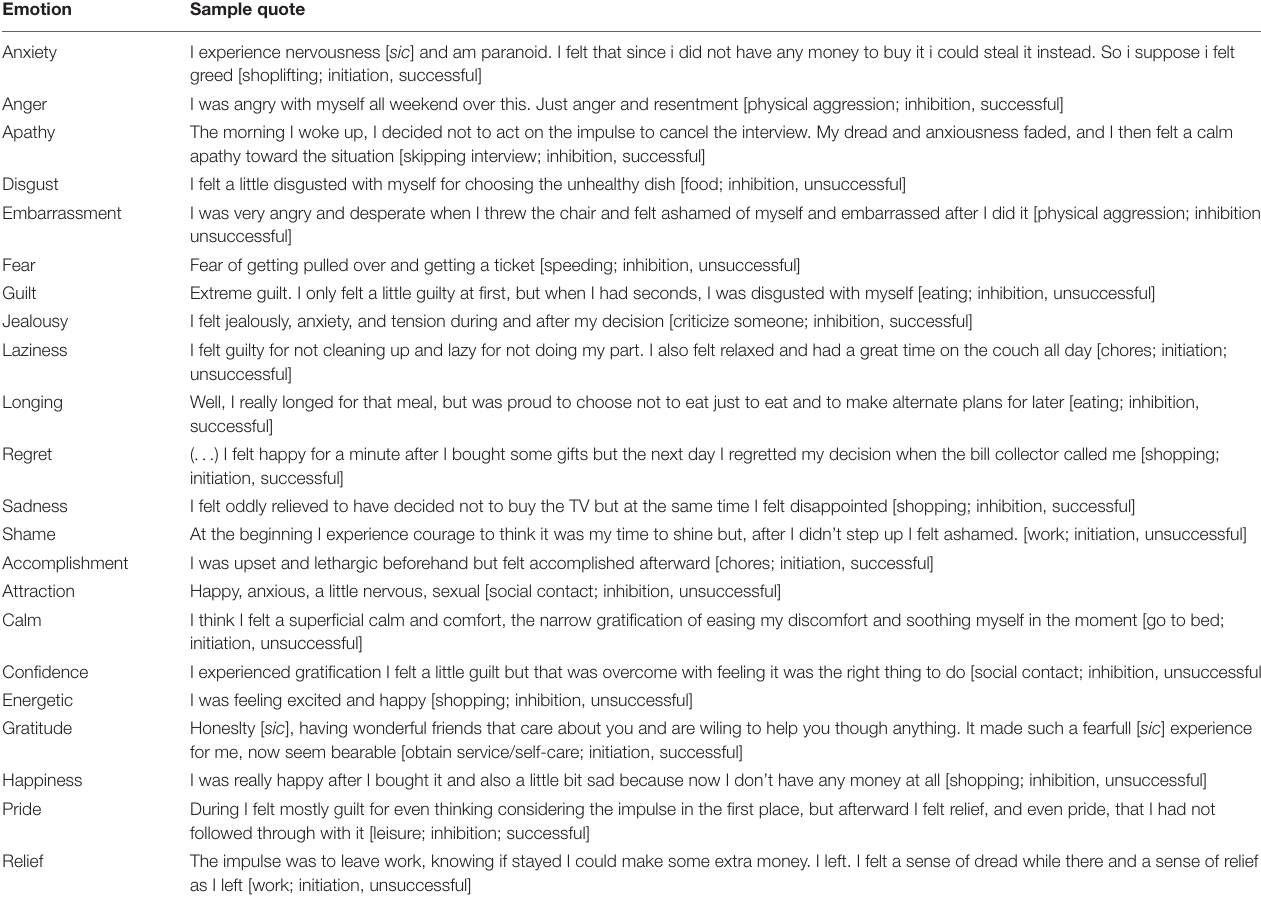
TABLE 2 | Sample quotes per emotion category. Emotion Sample